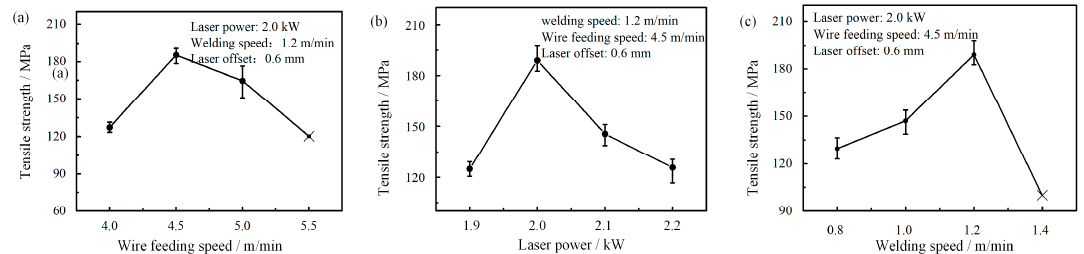
Figure 14. Effects of welding ‐ brazing parameters on the tensile strength of the joints: ( a ) Wire feeding speed; ( b ) Laser power; ( c ) Welding speed.